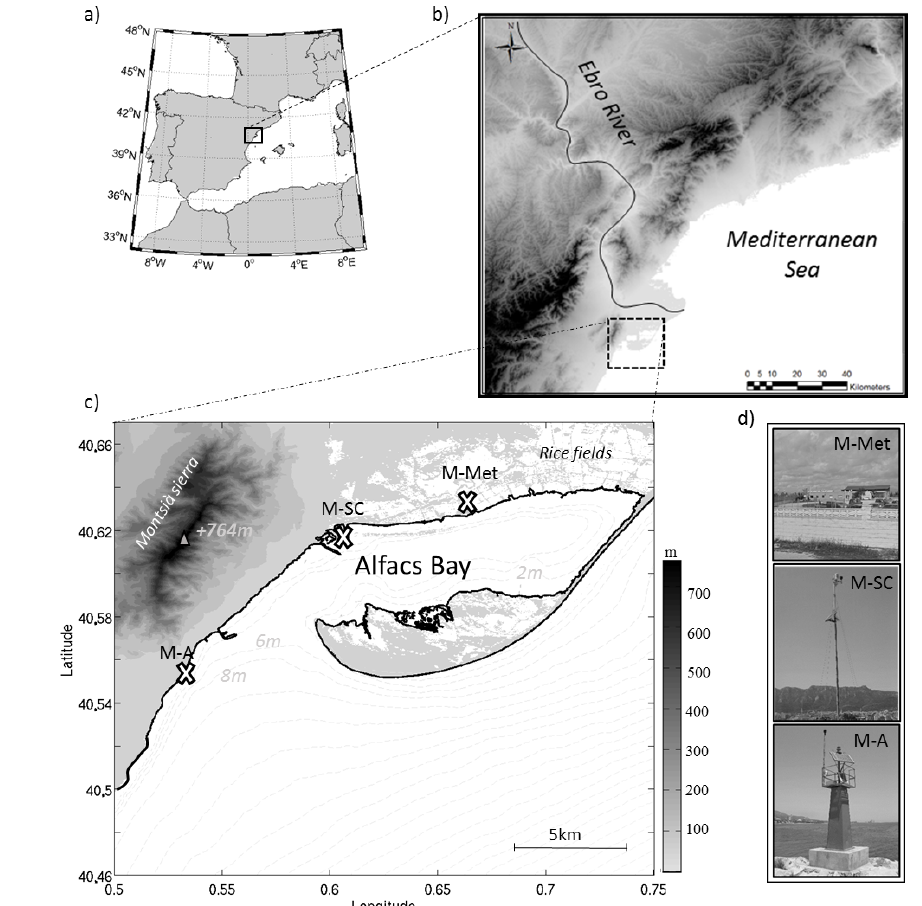
Figure 1. (a) Location map. (b) Ebro River delta region, with Alfacs Bay delimited by dashed square. (c) Study area showing meteorological stations (white crosses): M-A for Les cases d’Alcanar station, M-SC for Sant Carles de la Ràpita harbour station and M-Met for Meteocat station. Colour bar indicates altimetry above mean sea level. The bathymetry is also shown (isobaths, each 2m). (d) Meteorological stations